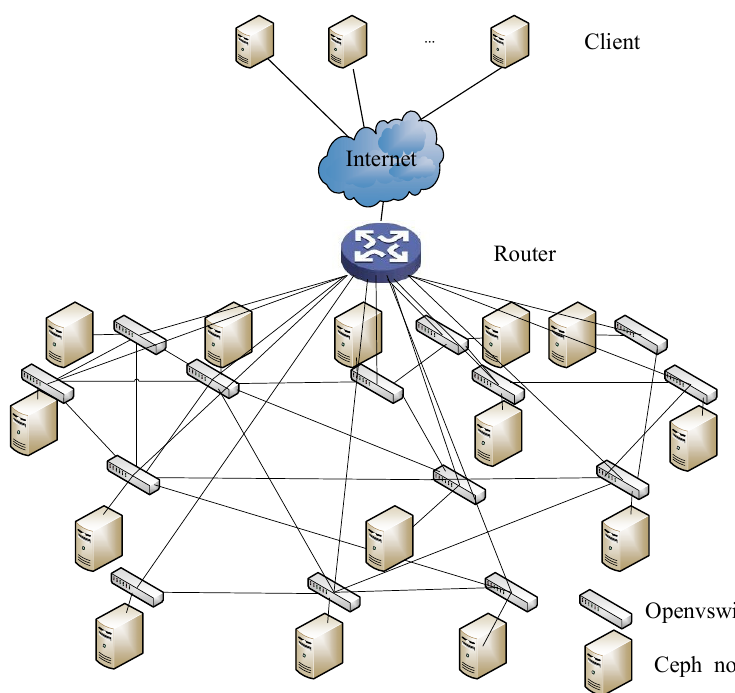
Figure 9. New York Center network topology simulation by mininet.